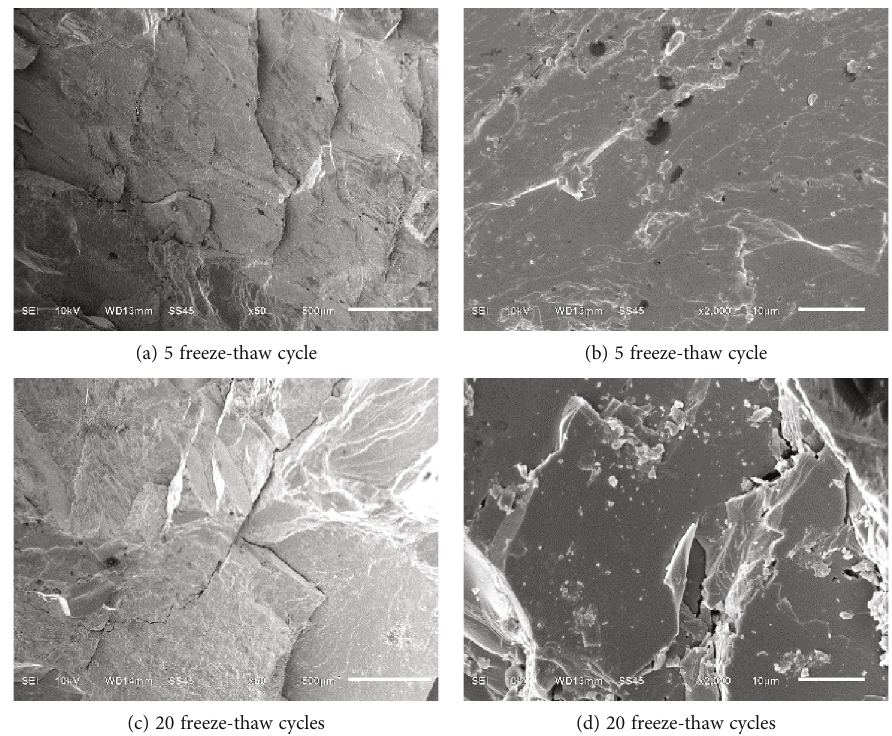
Figure 11: SEM images of granite at 50 and 2000 times under di ff erent number of freeze-thaw